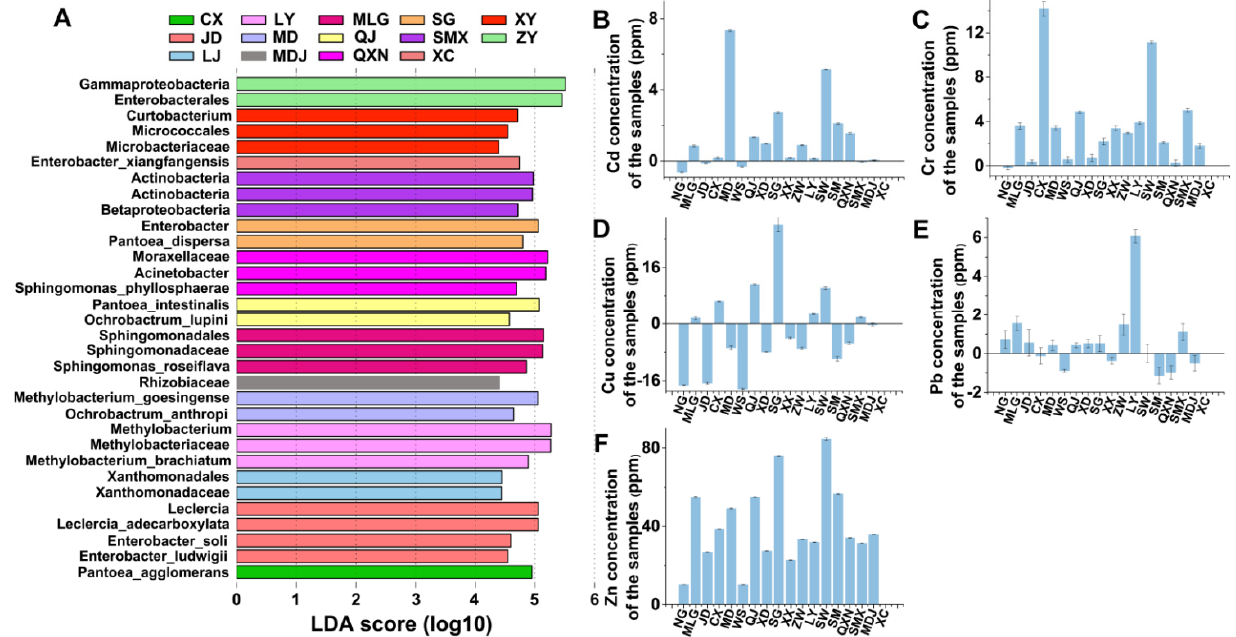
Figure 5. LEfSe analysis and heavy metal concentration determination. ( A ) LEfSe (linear discriminant analysis effect size). The ordinate is the taxon that differs significantly between groups; the abscissa visually shows the LDA difference analysis logarithm score (LDA > 2, p < 0.05) for the corresponding taxon (as a bar graph). ( B ) The concentration of Cd. ( C ) The concentration of Cr. ( D ) The concentration of Cu. ( E ) The concentration of Pb. ( F ) The concentration of Zn. Negative values refer to no ions present. NG, negative group; CX, Chuxiong; LY, Luoyang; MLG, Mengligong; SG, Shigang; XY, Xiangyang; JD, Menglijiaojidi; MD, Mangdui; QJ, Qujing; SMX, Sanmenxia; ZY, Zhuyang; LJ, Lijiang; MDJ, Mudanjiang; QXN, Qianxinan; XC, Xuchang. WS, Wenshan; XD, Xindian; ZW, Zhangwu; SW, Shaowu; SM, Sanming. Table 2. The significantly different species among the samples.